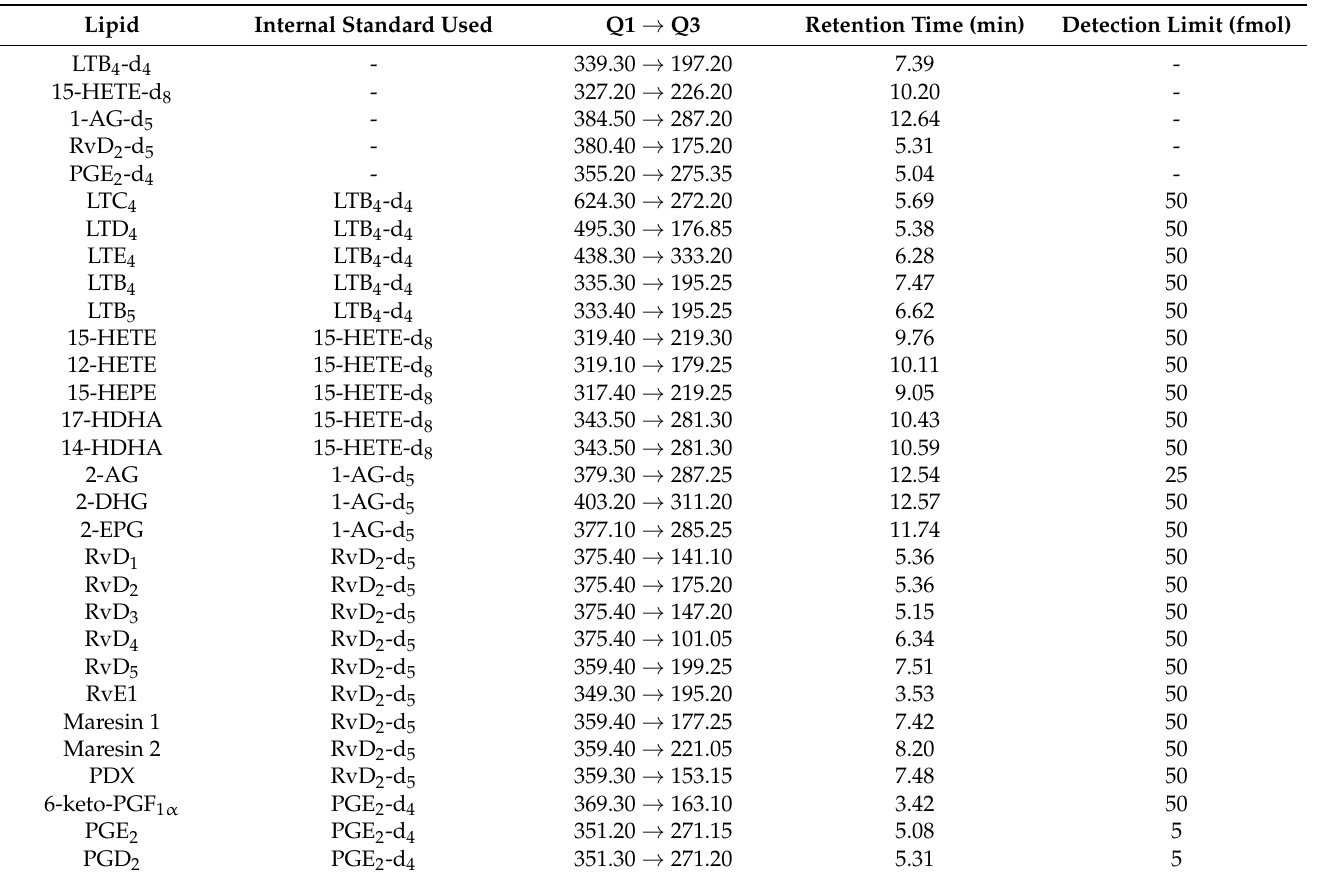
Table 1. Specific mass transitions of the lipid